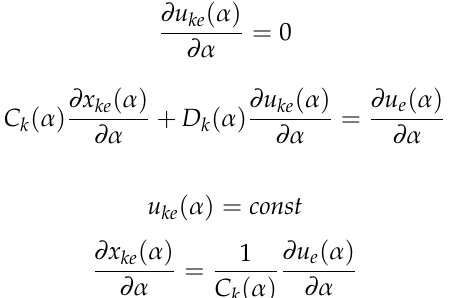
Figure 8. Polynomial fitted result of ( ) /